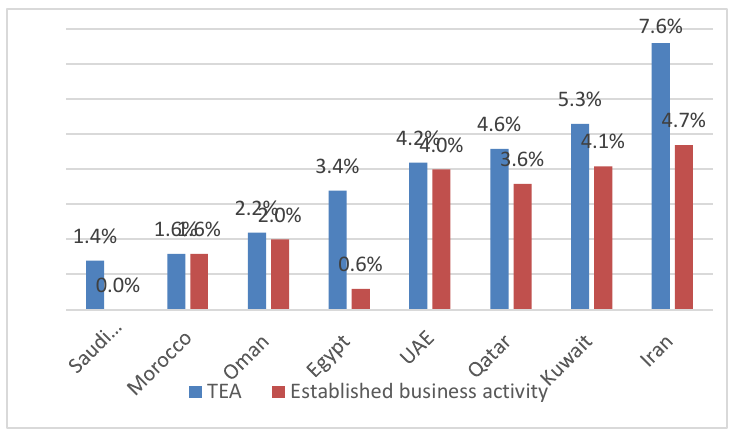
Figure 3 . Participation in the Medium and High-Technology Sector in Saudi Arabia and MENA Region; Source: Global Entrepreneurship Monitor, Kingdom of Saudi Arabia National Report 2020-2021